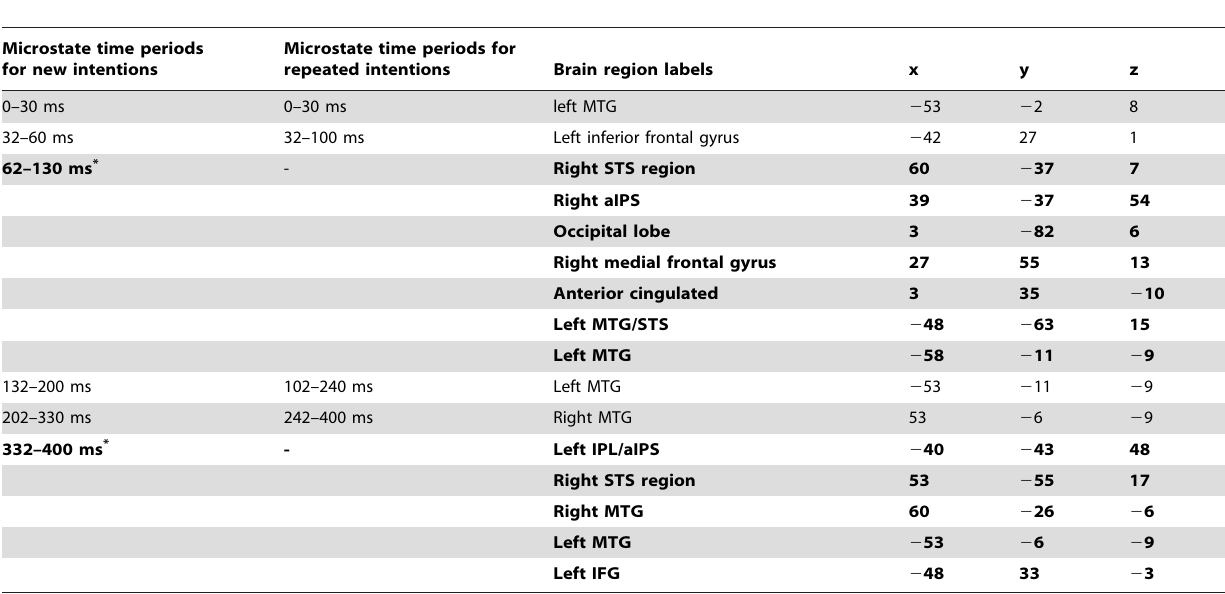
Table 3. Local maxima of current source density obtained from LAURA brain source estimations of EEG data for new and repeated